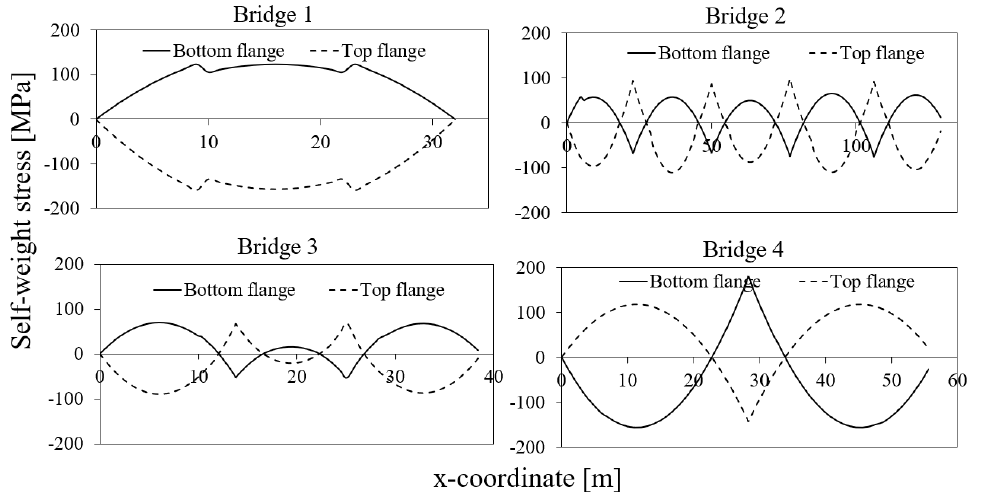
Figure 6. Self-weight stresses distribution along the bridges adapted from [13].